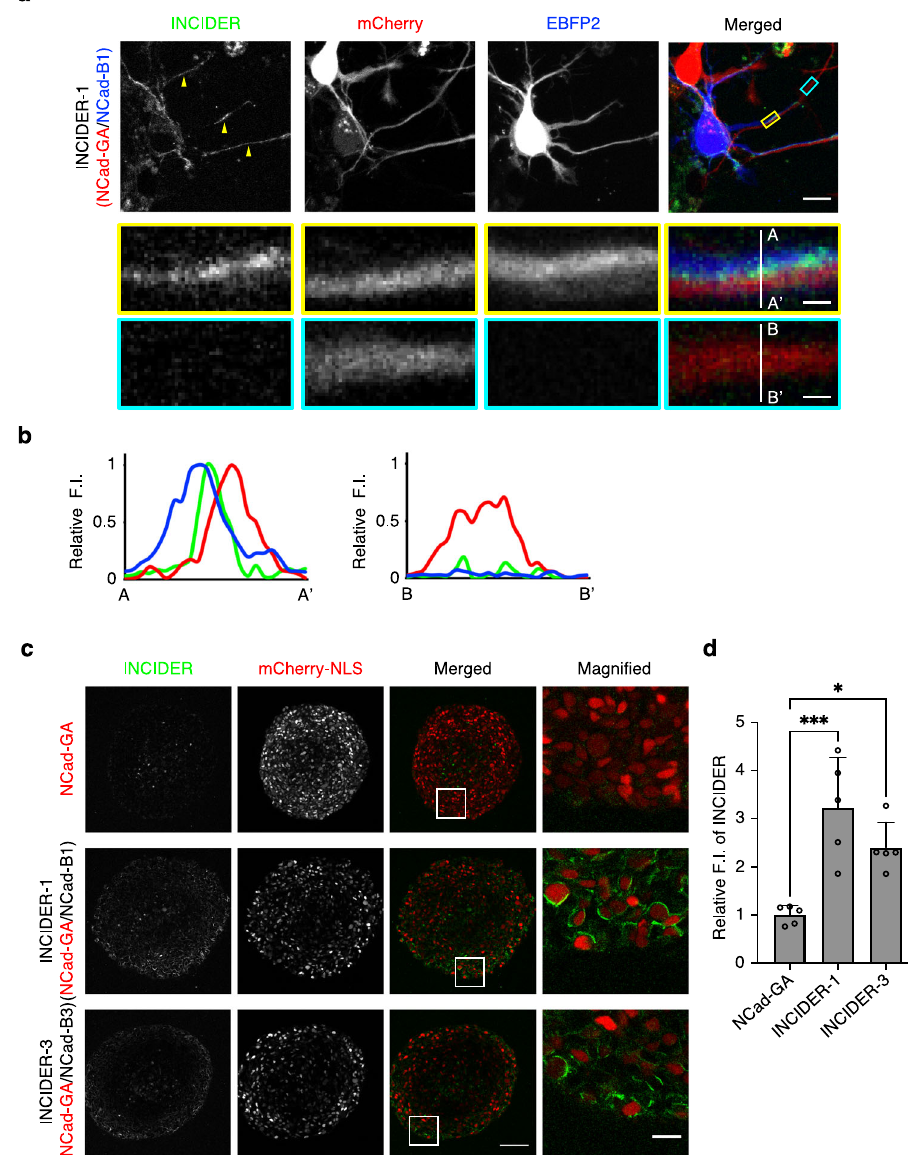
Fig. 6 Application of INCIDERs to various samples. a Fluorescence images of intercellular NCad interaction in neurons visualized by INCIDER-1. Dissociated cortical neurons individually expressing INCIDER-1 components (NCad-GA and NCad-B1) were co-cultured and observed using a confocal microscope at 2 DIV. mCherry and EBFP2 were bicistronically co-expressed with NCad-GA and NCad-B1, respectively, to differentiate cells and visualize cell morphology. Scale bar, 20 μ m (upper) and 5 μ m (lower). 102 fi elds of view from six independent experiments were observed. b Fluorescence intensities along the white lines across a neuronal process of an NCad-GA-expressing neuron with (from A to A ′ ) or without (from B to B ′ ) a process of an NCad-B1-expressing neuron. Relative fl uorescence intensities of mCherry, EBFP2, and INCIDER are represented by red, blue, and green, respectively. c Intercellular NCad interaction in spheroids visualized by INCIDERs. Spheroids formed by the L cells stably expressing the indicated NCad constructs were observed using a two-photon microscope. mCherry-NLS is a hallmark of NCad-GA-expressing cells. Scale bar, 100 μ m (left) and 25 μ m (right). d Mean values of green fl uorescence from the indicated spheroids were quanti fi ed and normalized by that of the spheroid consisting of NCad-GA-expressing cells. Data are presented as relative mean values ± SD. Signi fi cant differences were analyzed by ordinary one-way ANOVA, followed by Dunnett ’ s multiple comparisons test, with a single pooled variance. *** p < 0.001, * p < 0.05. In all samples, 5 spheroids from two independent experiments were